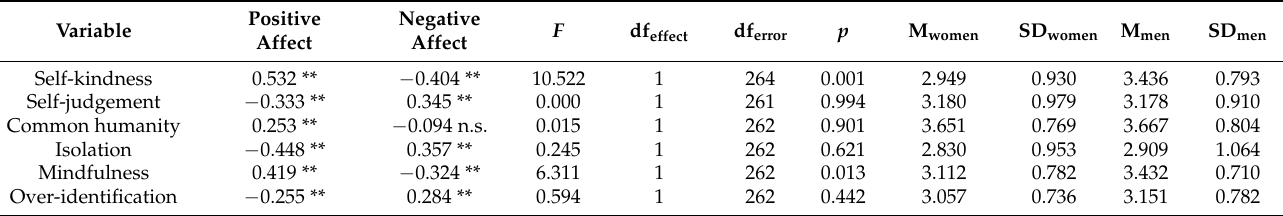
Table 4. Criterion-related validity results for the Spanish SSCS–L.